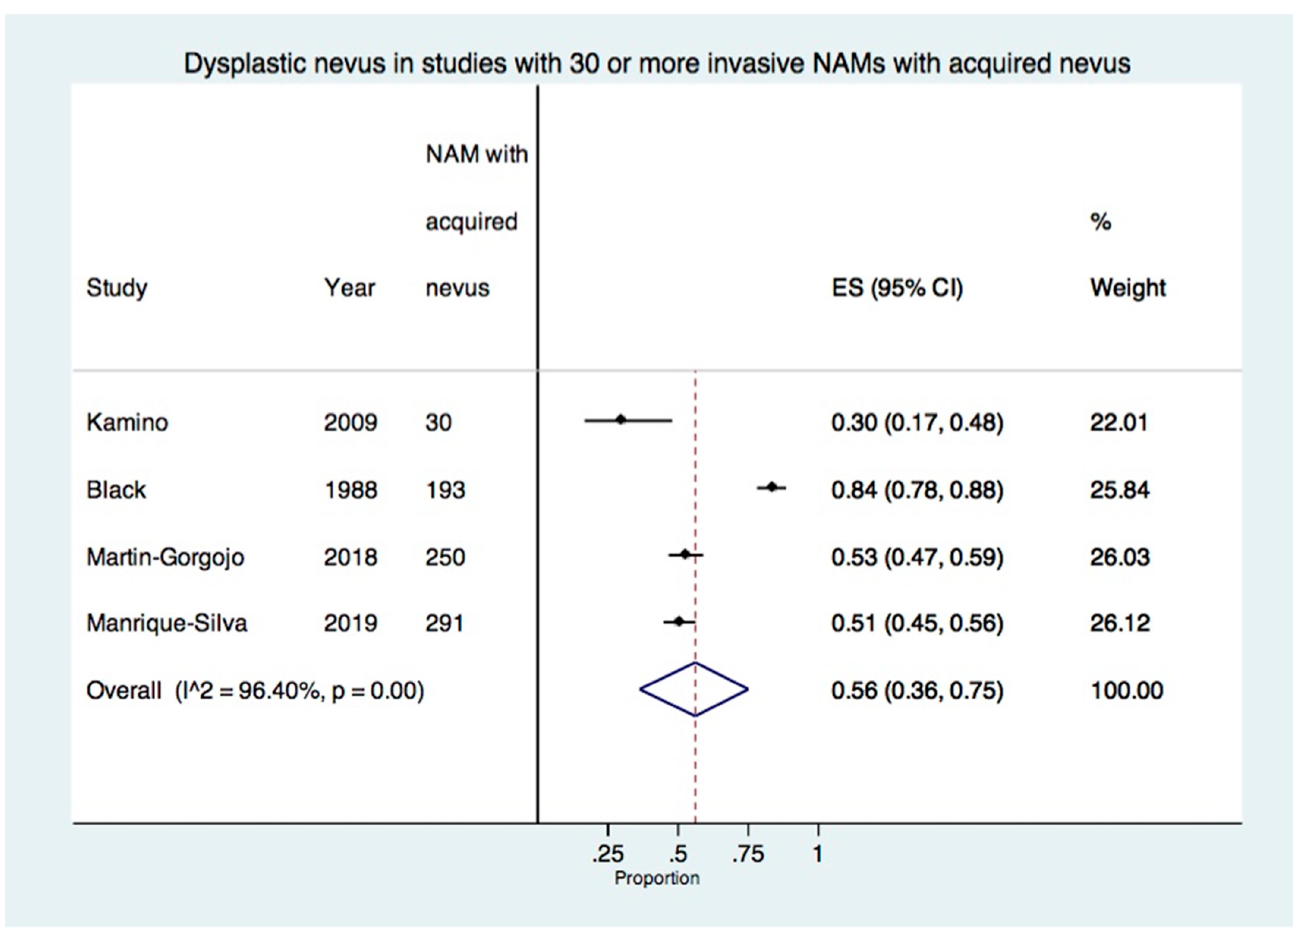
Figure 4. Forest plot of the proportion of dysplastic nevus in studies with 30 or more invasive-only acquired nevus NAMs (4 studies, 764 invasive-only acquired nevus NAMs).